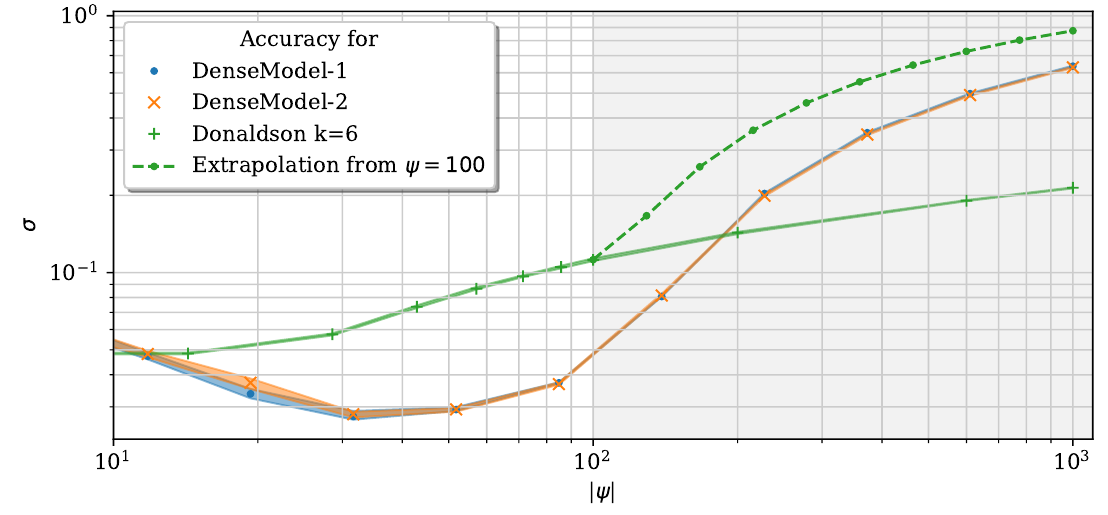
Figure 4 . σ accuracies at k = 6 achieved by the dense network with one and two hidden layers. The shaded area indicates the range of | ψ | that was not used during training, and thus shows the extrapolation behavior of the networks. For reference, the σ accuracy achieved by Donaldson’s algorithm for the same range of | ψ | is shown. The dashed line corresponds to the extrapolation of using Donaldson’s balanced metric at ψ = 100 over real values of ψ . The error band in each case corresponds to the maximal and minimal value obtained respectively when evaluating the σ accuracy at different